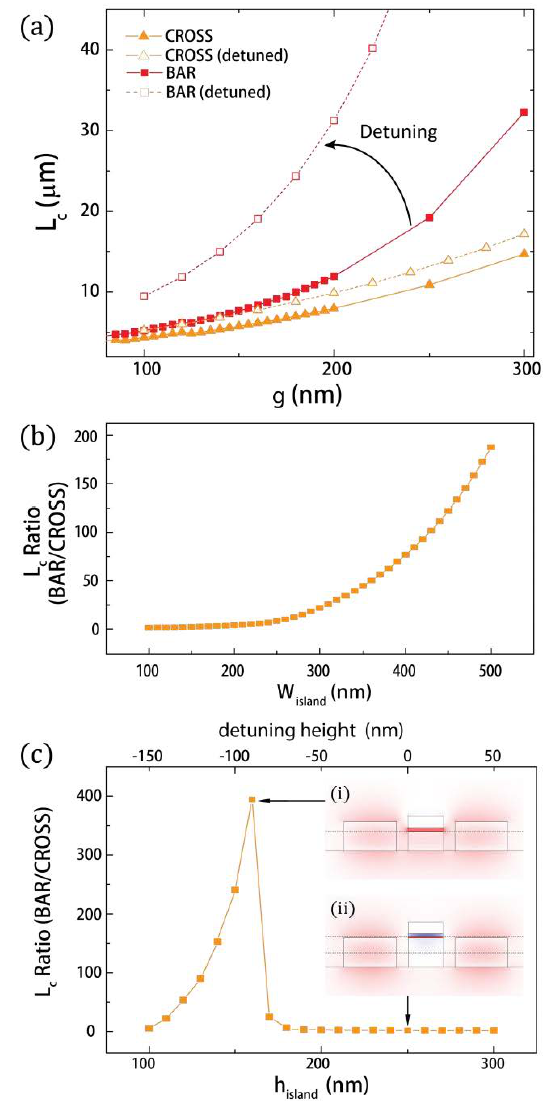
Figure 2: (a) Coupling length ( L c ) as a function of gap ( g ). Proce- dure: for a selected h island and h WG an optimized d SiO 2 is obtained with the eigenmode condition. The gap is swept from 80 to 300 nm and L c is recorded. By detuning the Silicon waveguide core dimen- sions of the MOS island (160 nm) with respect to the SOI in/output waveguides (250 nm) a higher coupling length at BAR state can be achieved (arrow). (b) The L c ratio increases gradually with ex- tending the MOS island width, W island . (c) Coupling length ratio ( L c ratio) as a function of Silicon core height ( h island ). The ratio between the CROSS and BAR state’s coupling length reaches its maximum at the height of 160 nm. Procedure: for a selected W island (300 nm) an optimized d SiO 2 is obtained with the eigenmode condition. Then the h island is swept from 100 to 300 nm and L c is recorded. By de- tuning the Silicon waveguide core dimensions of the MOS island, the L c ratio increases first, and then decreased with a lower de- tuning height. The insets show the TM supermode profiles at the particular h island positions (arrow